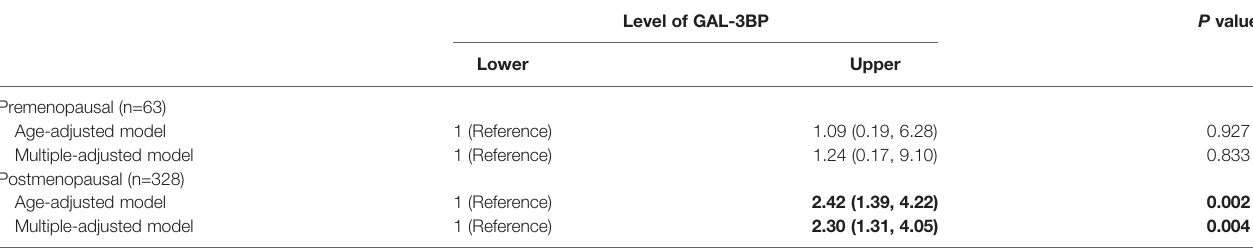
TABLE 3 | Association between Gal-3BP level and MetS in female